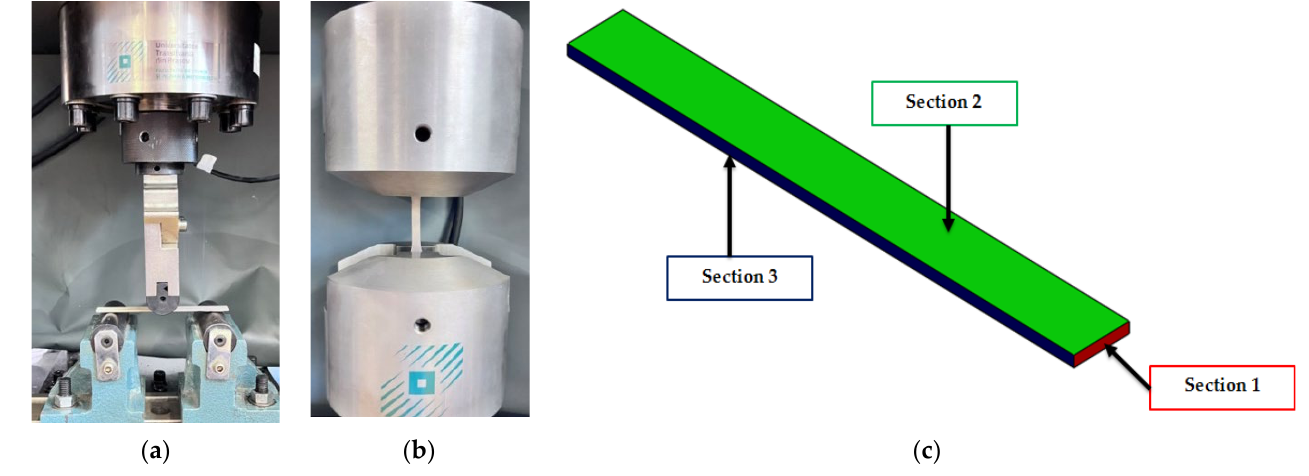
Figure 3. Testing and analysis of specimens: ( a ) three-point bending test; ( b ) tensile testing; ( c ) establishment sections for microscopic analysis.